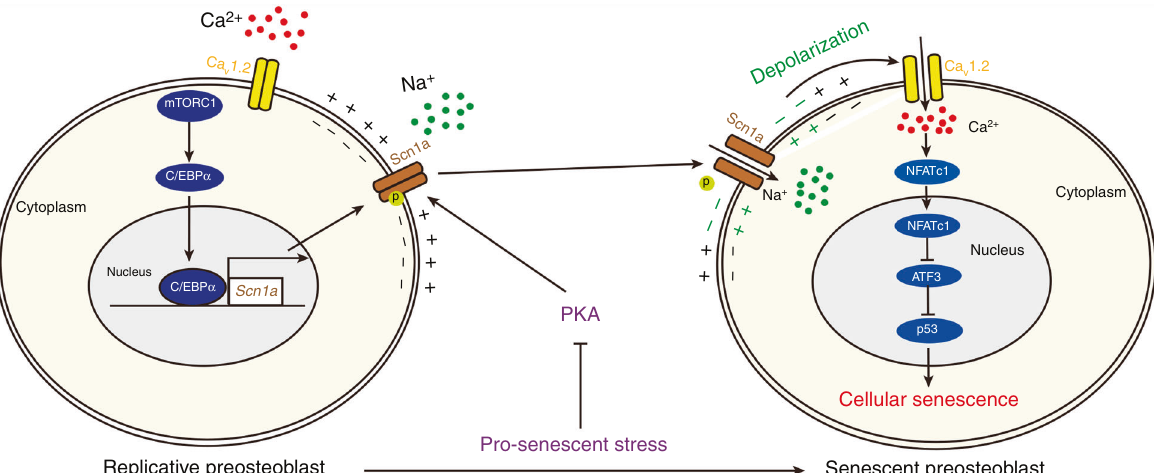
Fig. 9 Model of the sodium channel Scn1a in regulating preosteoblast senescence. Scn1a expression is positively regulated by mTORC1 upstream of C/EBP α , whereas its permeability to Na + is gated by protein kinase A (PKA)-induced phosphorylation. Prosenescent stresses increase the permeability of Scn1a to Na + by suppressing PKA activity and induce depolarization in preosteoblasts. Depolarization increases Ca 2 + in fl ux and activates downstream NFAT/ATF3/p53 signaling, thus promoting preosteoblast